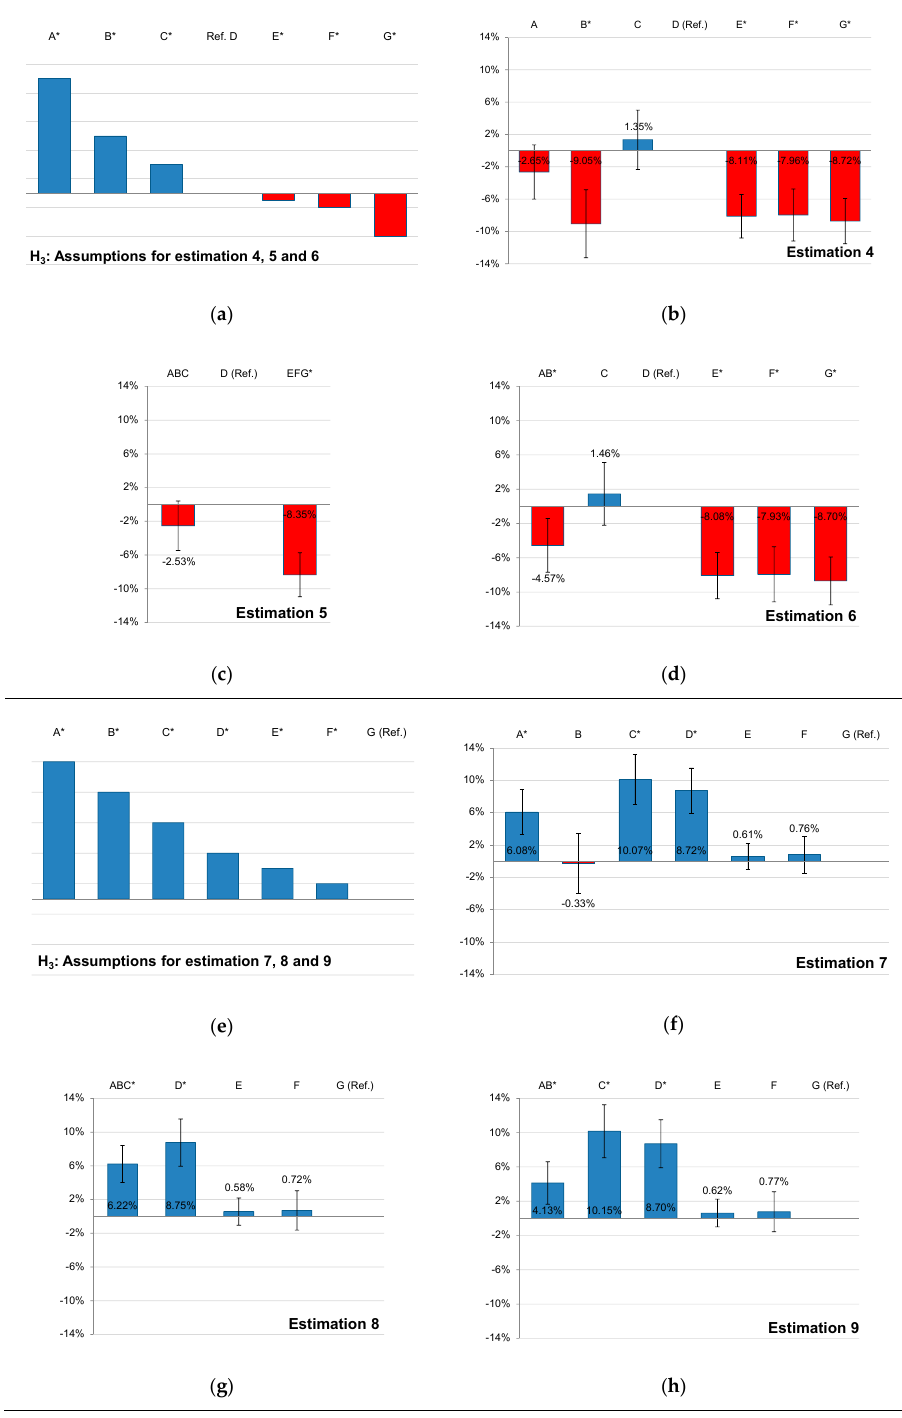
Figure 10. Bar graphs with asking price premiums (%) and CI (95%) for estimations 4 to 9 of